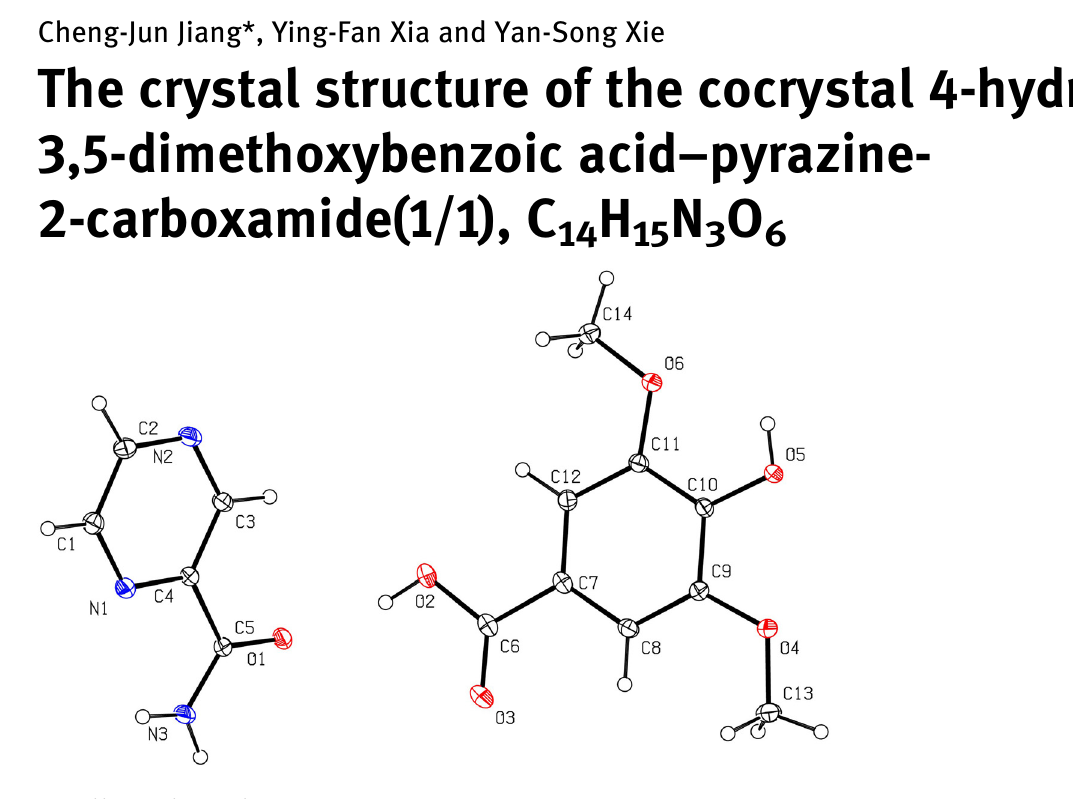
Table  : Data collection and